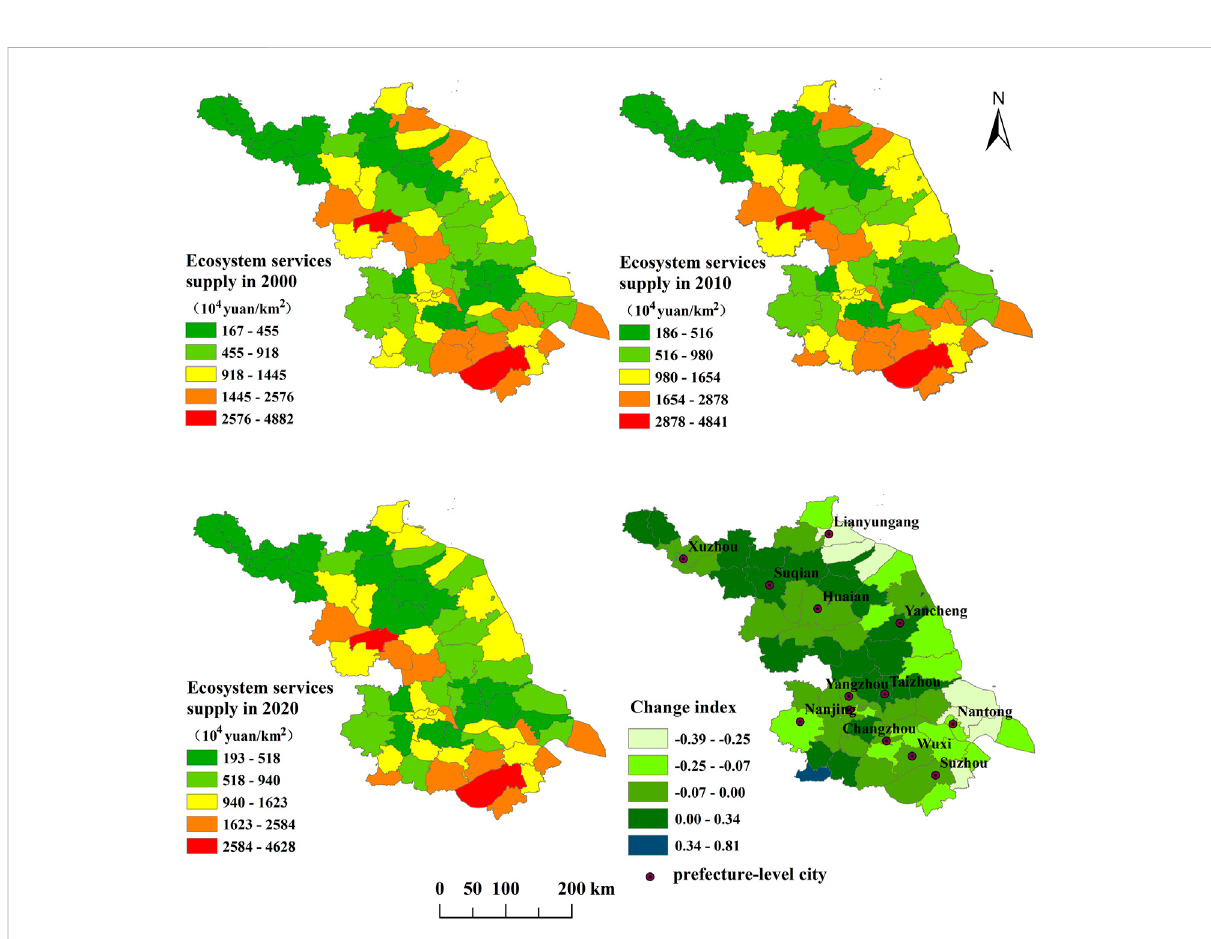
FIGURE 3 Distribution pattern of and changes to the ecosystem service supply in Jiangsu Province from 2000 to